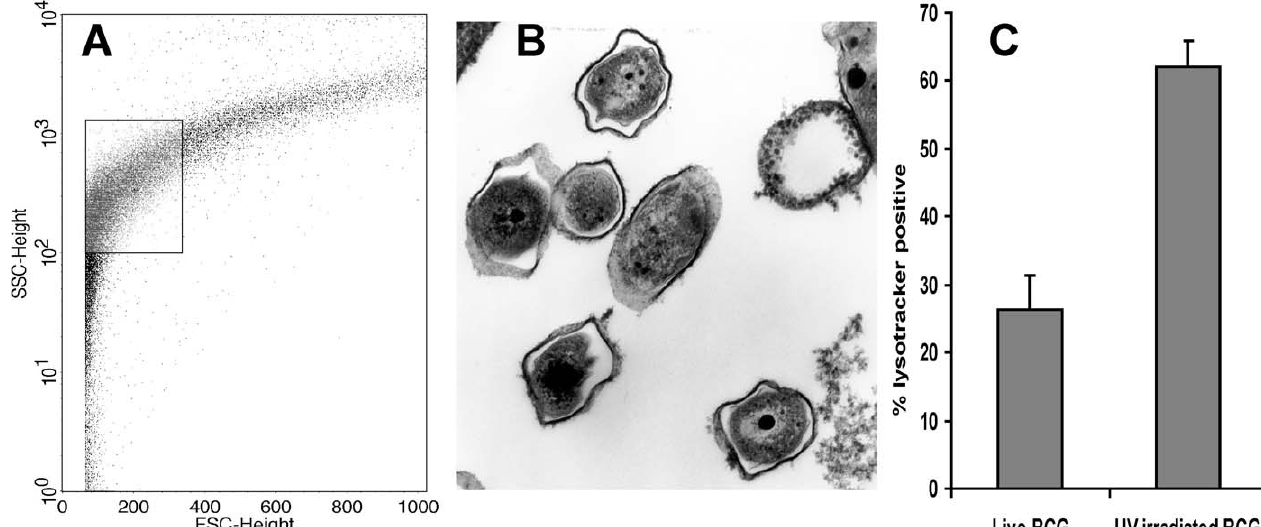
Figure 3. Fluorescence-Activated Cell Sorting of Mycobacterial Phagosomes (A) Forward and side scatter plot of organelle preparation from BCG-infected J774 macrophages. Gated area denotes the population which includes mycobacterial phagosomes, based on the signal from FITC-labelled mycobacteria. (B) Using fluorescently labelled mycobacteria, phagosomes were sorted into fixative for confirmation of identity and integrity. Fluorescent events in the gated population predominantly consisted of mycobacterial phagosomes with bacteria surrounded by intact membranes. (C) Flow cytometric analysis of acidification of mycobacterial phagosomes using the acidotropic dye LysoTracker DND99. Significantly more UV-killed BCG localised to acid compartments at 1 h post-infection ( p , 0.01). DOI: